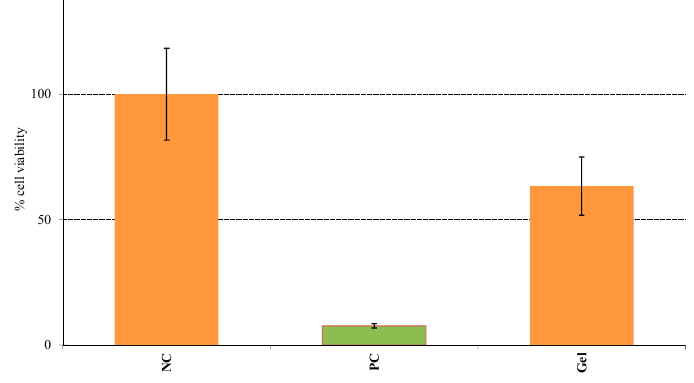
Figure 7. Skin irritation testing showed anhydrous gel to be non-irritant.